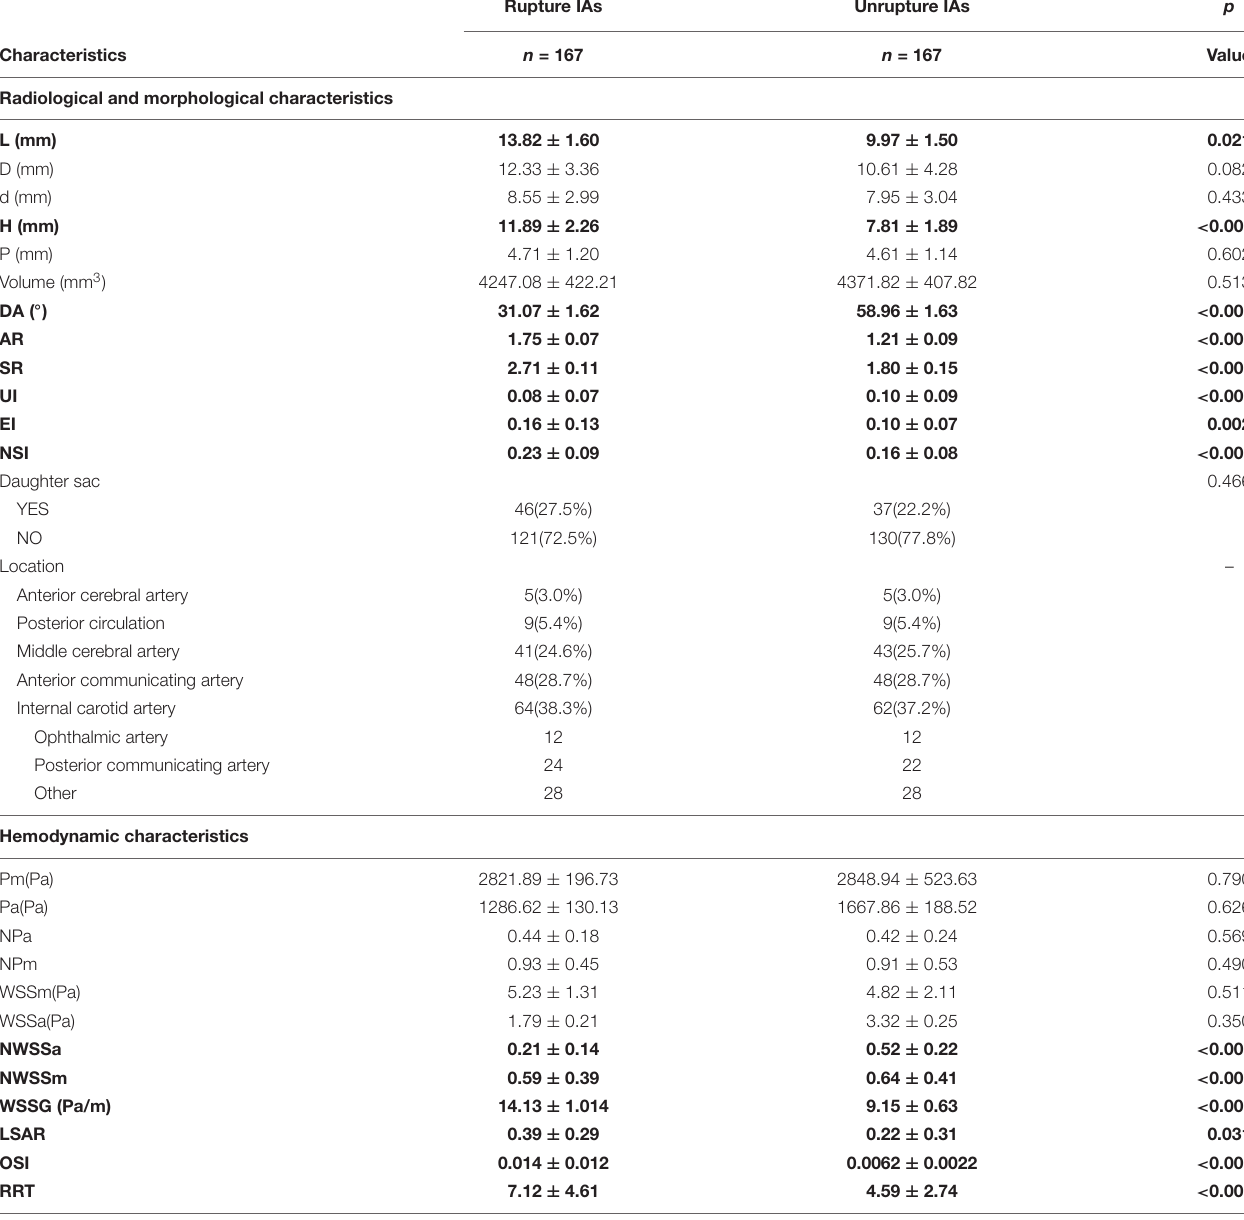
TABLE 2 | Radiological and morphological differences, and hemodynamic